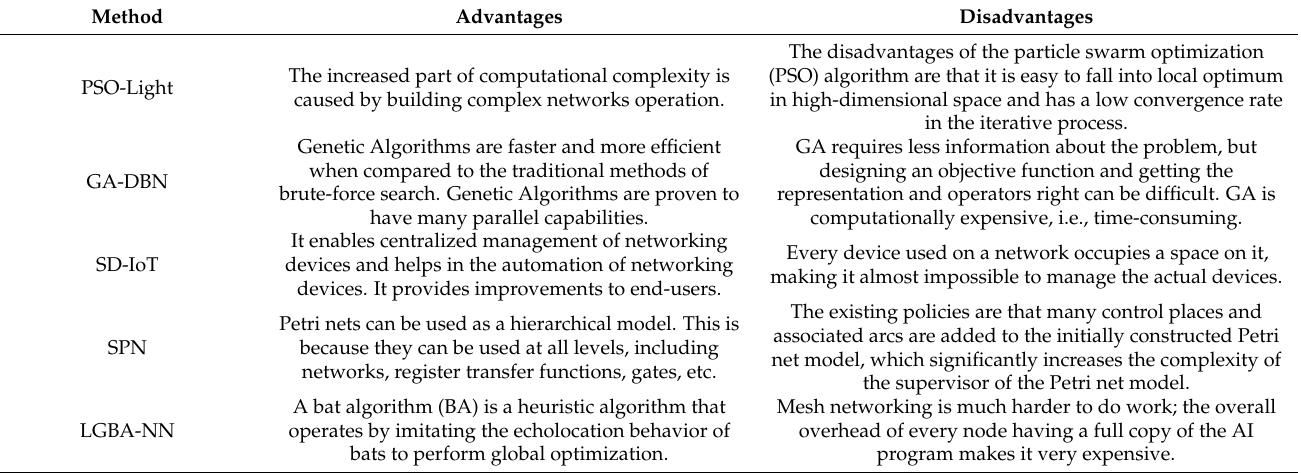
Table 2. Comparison of network intrusion detection